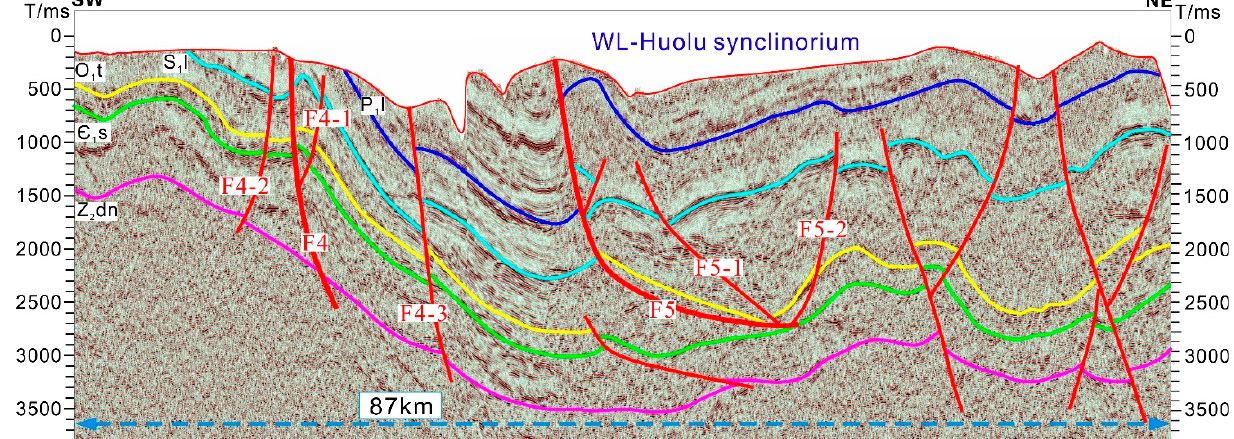
Figure 6. Seismic interpretation profile of L1. (F4: Chayuan fault, F5: Hujiayuan fault).